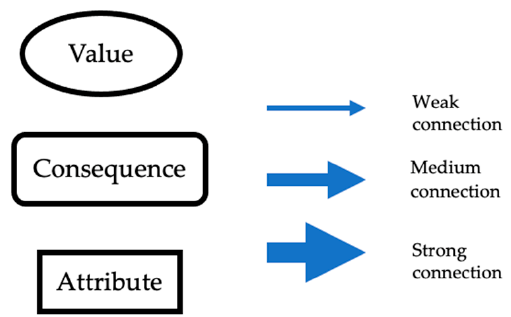
Figure 1. Legends of symbols used in hierarchical value map.